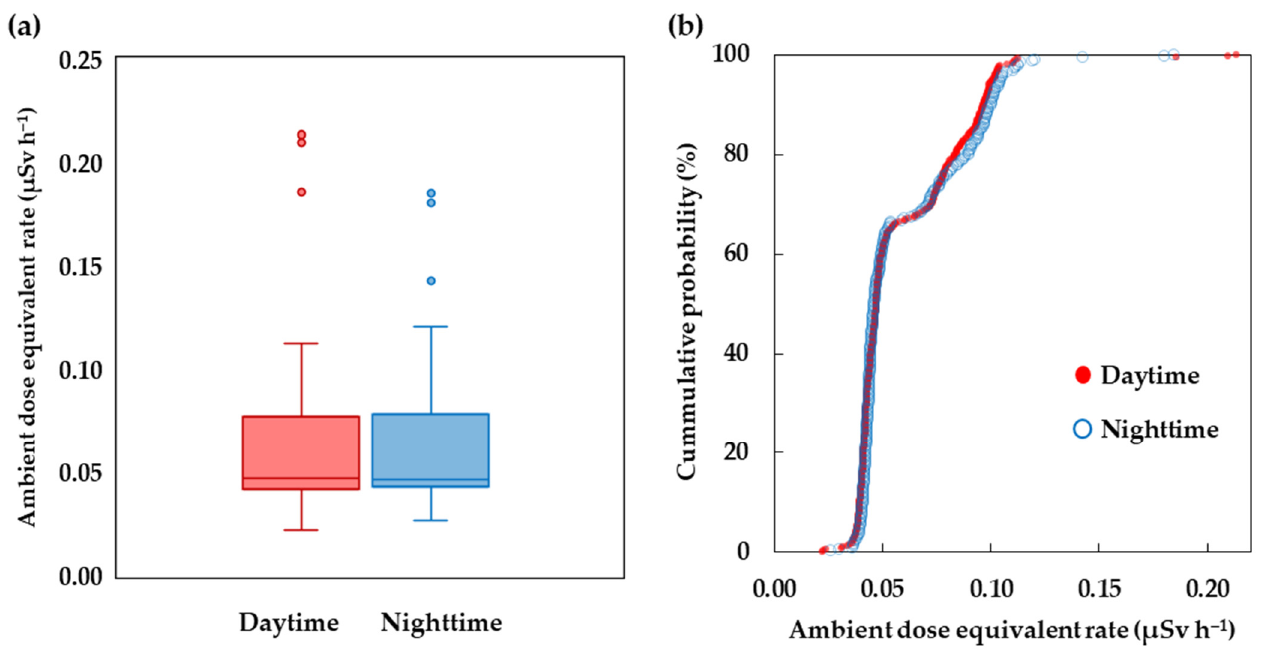
Figure 11. ( a ) Box plot of ambient dose equivalent rates during daytime (red block) and nighttime (blue block). The dotted circles represent outliers of the data. and ( b ) cumulative probability plot of ambient dose equivalent rates in air during daytime and nighttime.